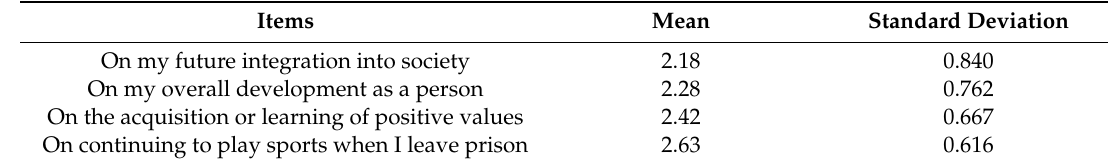
Table 5. Influence of the football program on personal a ff